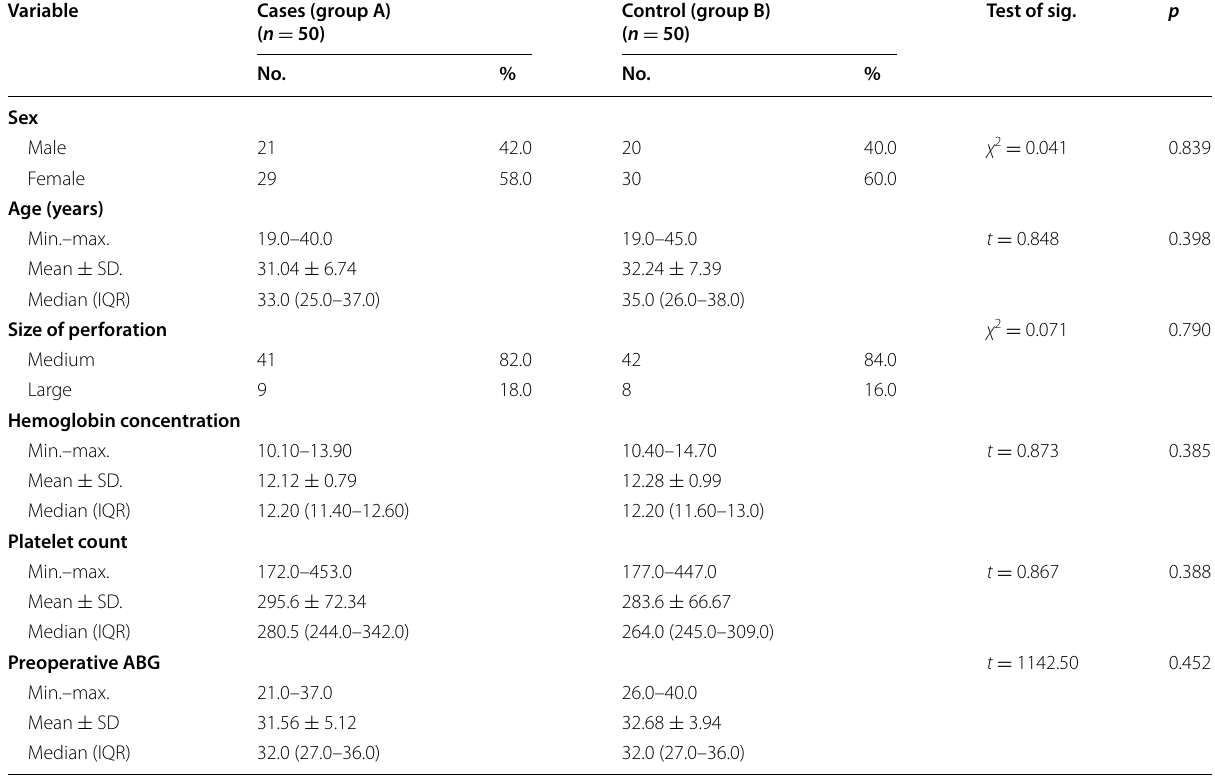
Table 1 Comparison between the two studied groups regarding the demographic and preoperative clinical data